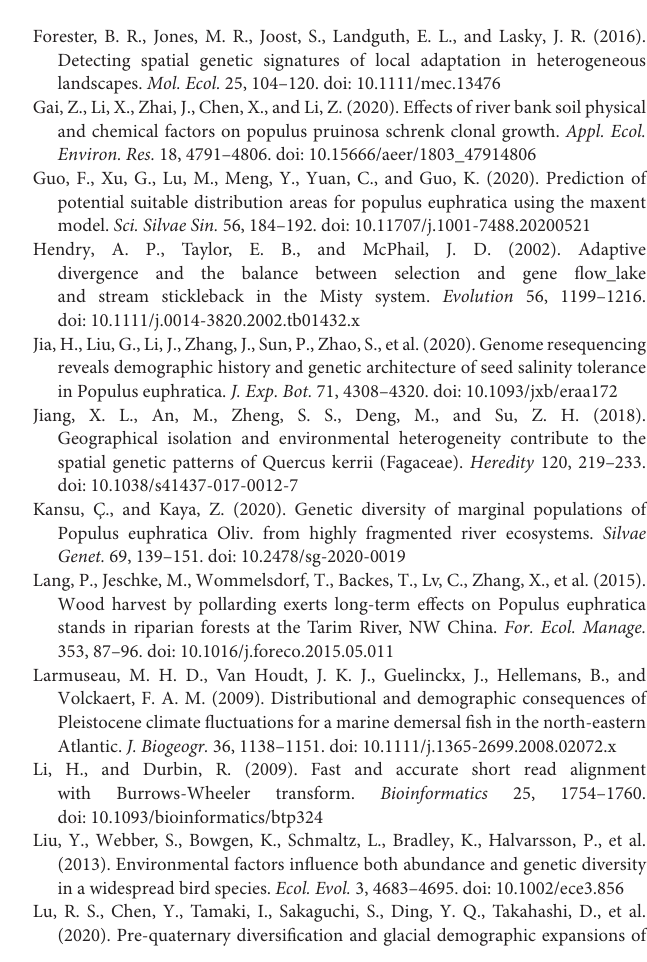
Supplementary Table 8 | Genetic differentiation coefficients among P. euphratica populations. Supplementary Table 9 | Genetic differentiation coefficients among P. pruinosa populations. Supplementary Figure 1 | Distribution of selected SNPs on the 19 P. euphratica